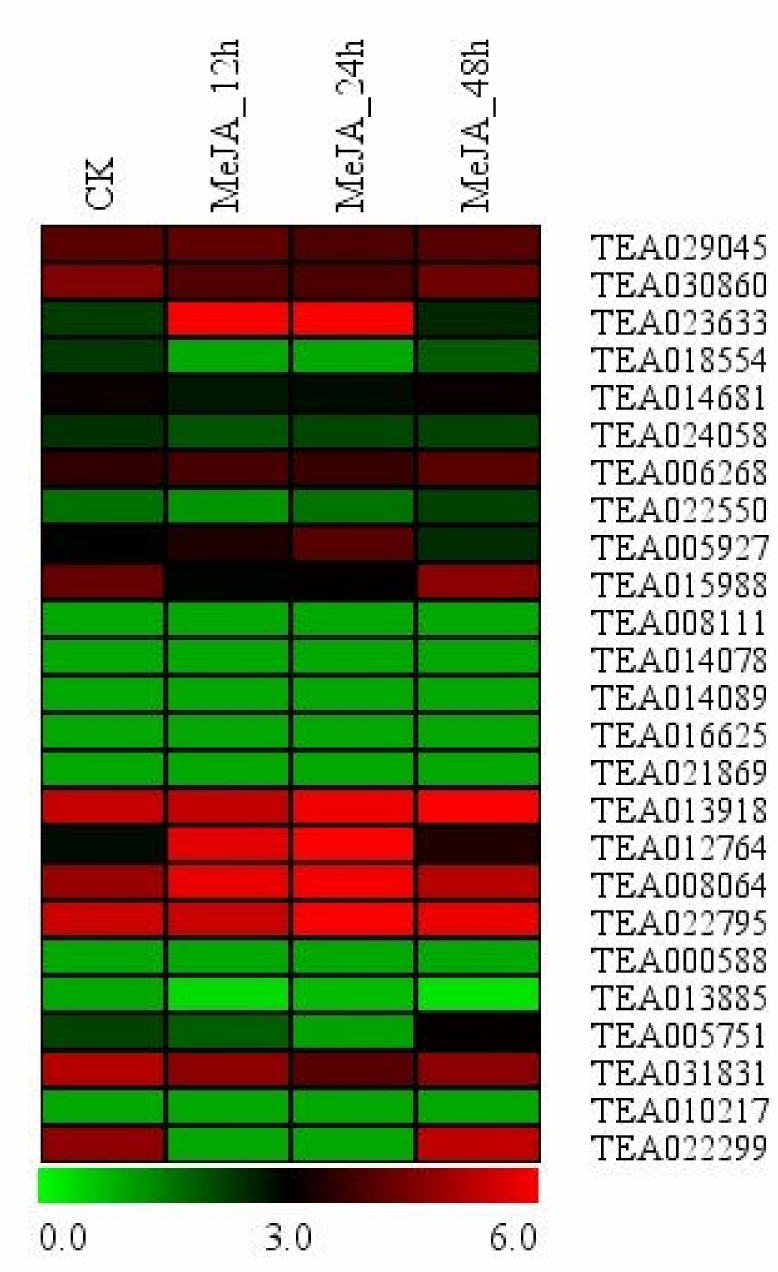
Figure 5. Expression patterns of Hsf genes in response to MeJA treatment. The heatmap was generated by MeV software (TIGR, Rockville, MD, USA) using the Hsf genes’ expression data, and normalized log 2 transformed values were used with hierarchical clustering. The red and green colors indicate higher or lower transcript abundances than those of the relevant control,